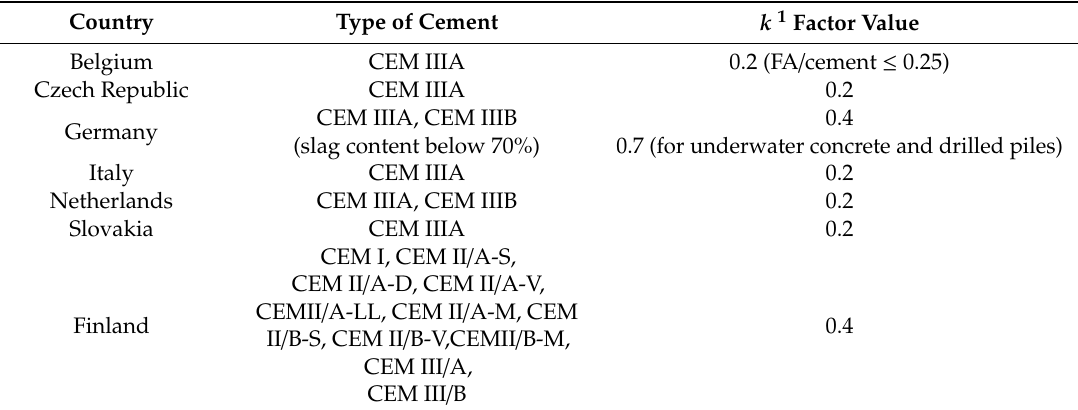
Table 1. European countries where the use of CEM III cement in concretes with fly ash additive is allowed. Country Type of Cement k 1 Factor